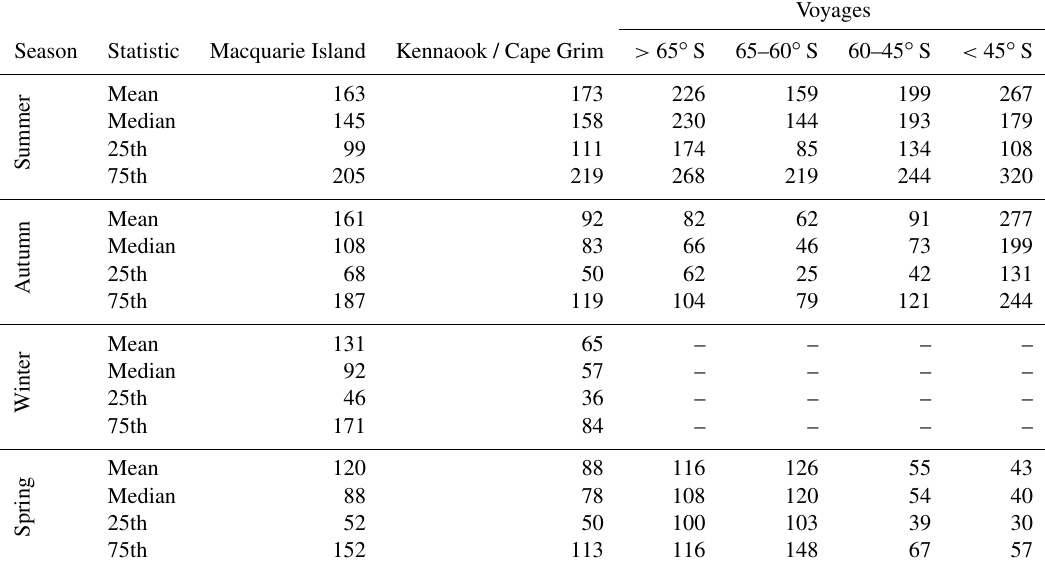
Table A2. Seasonal summary statistics from stations and voyages for CCN 0 . 5